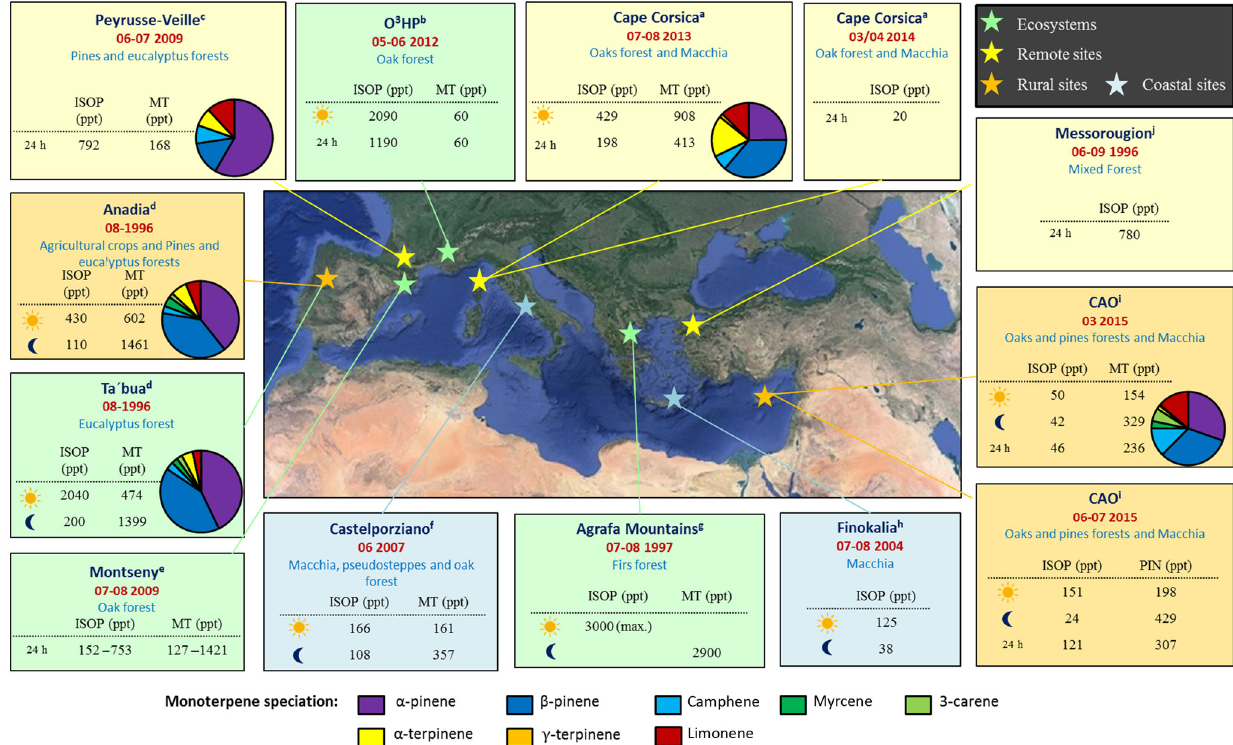
Figure 3. Comparison of mean concentrations (in ppt) and speciation (in %) of primary BVOCs with the ones observed in the literature in the Mediterranean region with different vegetation types. ISOP, MT and PIN are abbreviations, respec- tively, referring to isoprene, monoterpenes and pinenes. a Michoud et al. (2017), Kalogridis (2014), ChArMEx database. b Kalogridis et al. (2014). c Detournay et al. (2013). d Cerqueira et al. (2003). e Seco et al. (2011). f Davison et al. (2009). g Harrison et al. (2001). h Liakakou et al. (2007). i This study. j Moschonas and Glavas